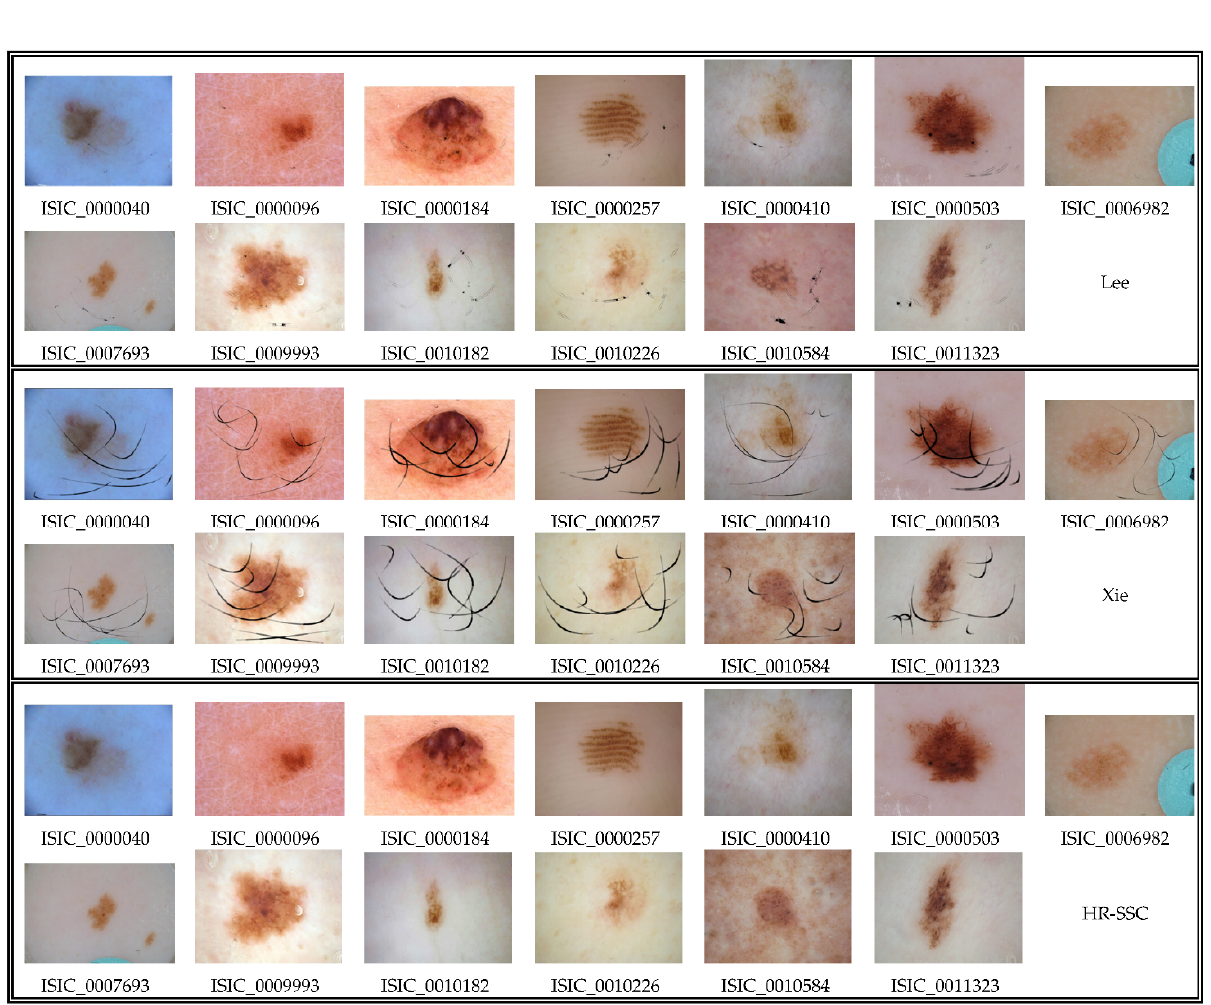
Figure 12 Results of methods Lee, Xie, and HR-SSC on sHSim-data . Figure 12. Results of methods Lee, Xie, and HR-SSC on sHSim-data . Based on the quantitative analysis using the nine metrics, the trend of the various methods turns out to be completely different on H13GAN-data and H13Sim-Data in com- parison with those on a set with greater cardinality HSim-data as well as on its sample sHSim-data of 13 images. This is highlighted in Figures 16 and 17, where the trends of each quality measure on the dataset containing 13 images belonging to different datasets but generated by the same HairSim method for the hair simulation, i.e., H13Sim-data and sHSim-data , are